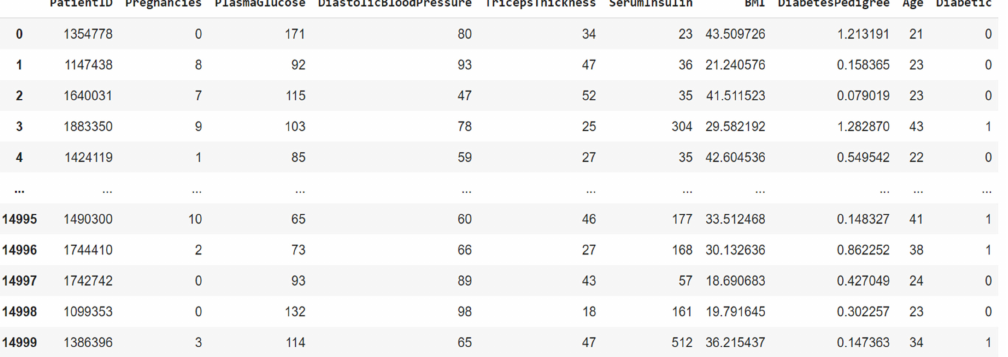
Figure 2. Data import for feature